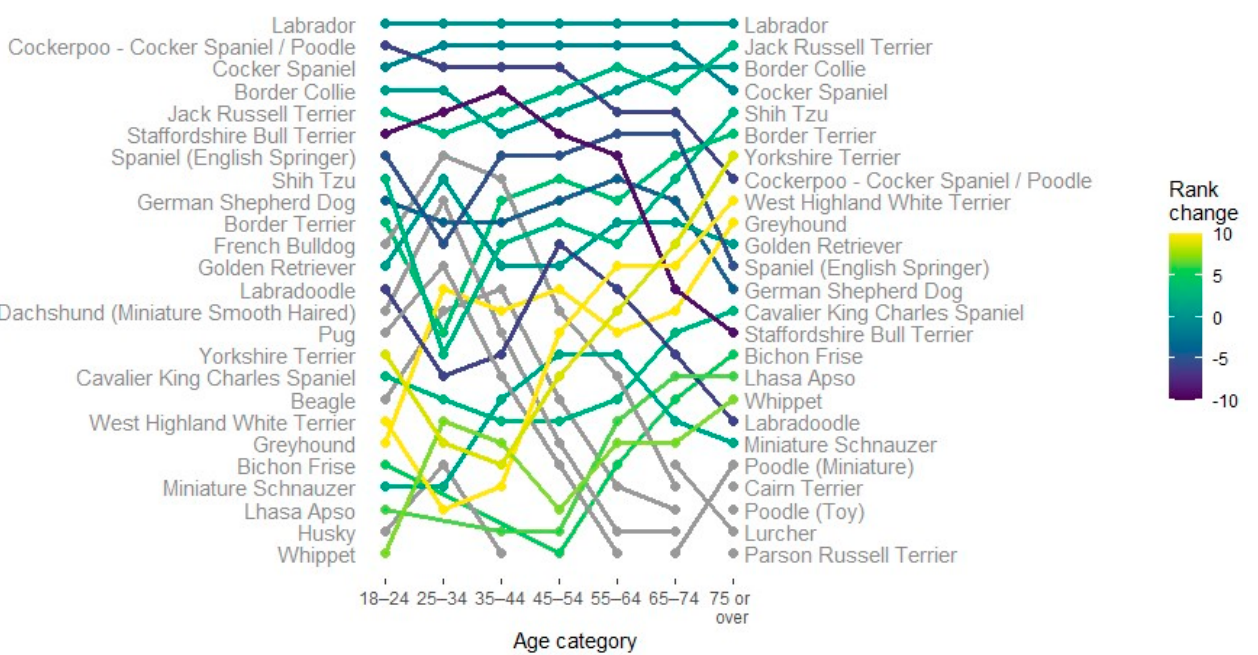
Figure 4. Chart showing the percentage of dogs acquired as broken down by month of acquisition.